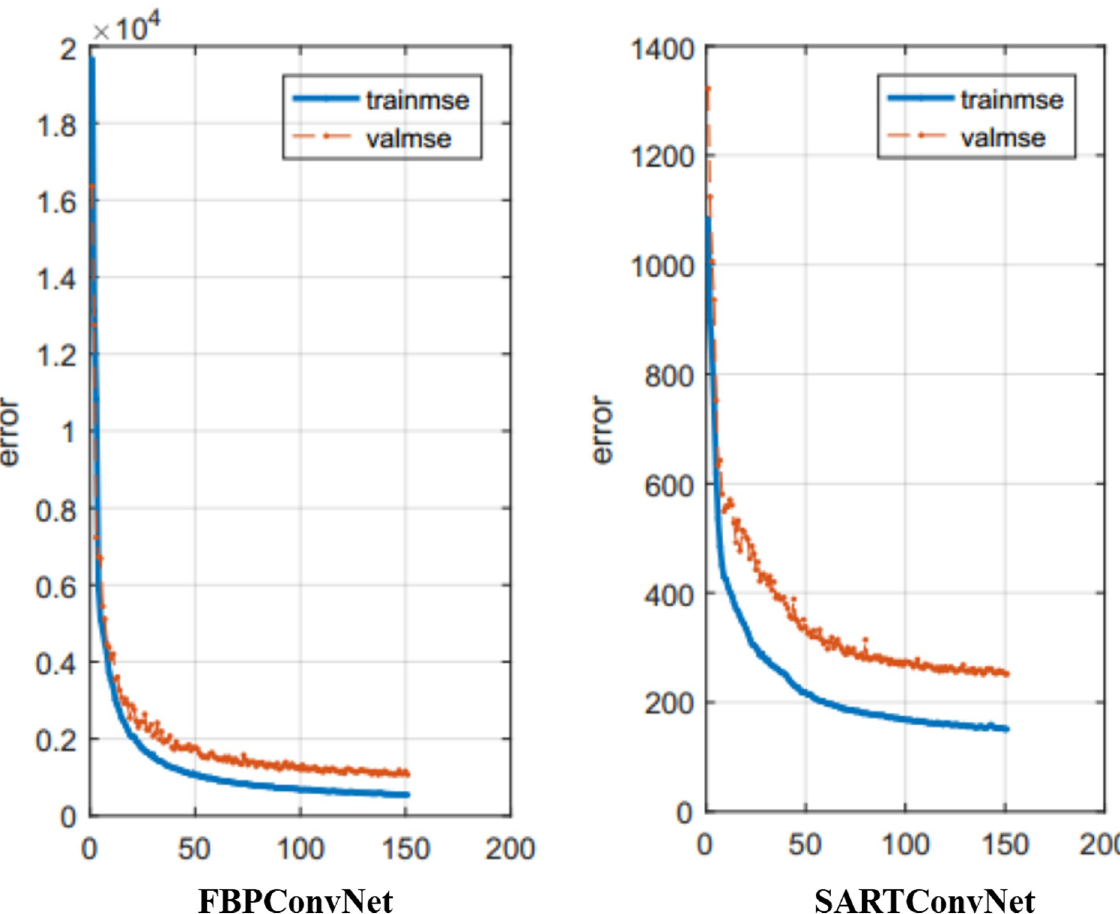
Fig 14. Loss function value changes in CNN training changes with epochs for both training dataset and testing